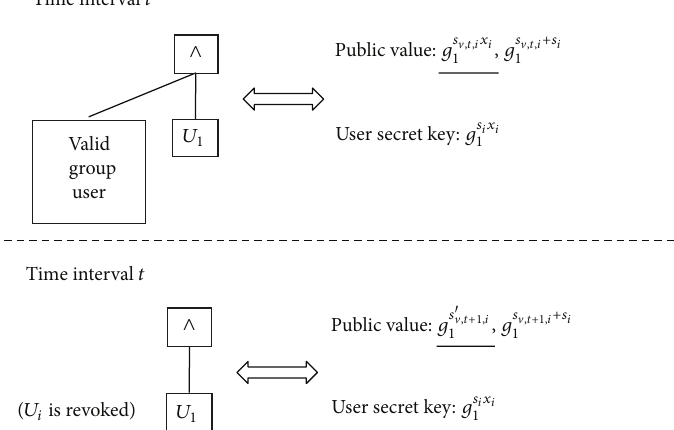
Figure 3: Our randomization and dummy attribute